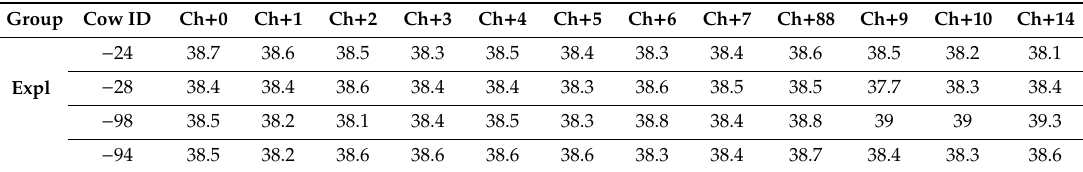
Table A1. Rectal body temperature during the challenge period. G: Group, cow ID: cow identification number (only last two digits were shown for the confidentiality of farm and cow identity), Expl: Experimental Group, Ctrl: Control Group. Ch0: Immediately before challenge. Ch + 1–Ch + 10: days 1 to 10 of challenge; Ch + 14: day 14 of